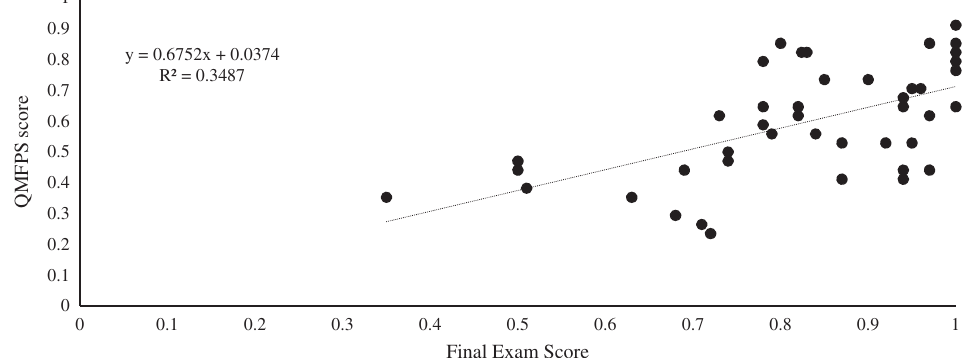
FIG. 3. Correlation between 44 graduate students ’ QMFPS scores and their final exam score in a core graduate level quantum mechanics course. The coefficient of determination is R 2 and the correlation coefficient is R ¼ 0 . 58